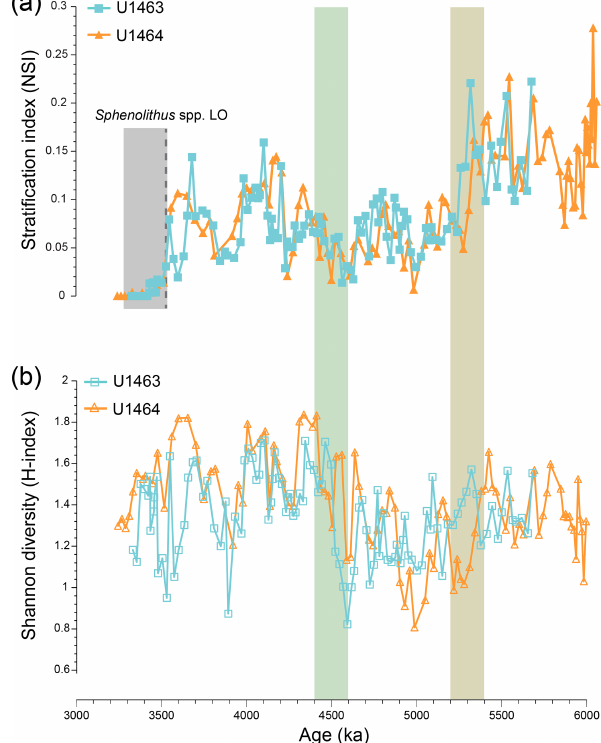
Figure 4. (a) Miocene to early Pliocene nannofossil stratification index (NSI) at IODP Sites U1463 (blue squares) and U1464 (orange triangles). The dashed grey line indicates the last occurrence (LO) of Sphenolithus spp. during the early Pliocene ( ∼ 3 . 54Ma). There- fore, this NSI cannot be used for younger samples (grey shading). (b) Shannon diversity ( H index) at the same sites. The brown shad- ing highlights the stepwise decrease in NSI and the increase in NAR of bloom-forming species. The green shading represents the inter- val of significant decreases in paleoproductivity (PP) and NAR of bloom-forming